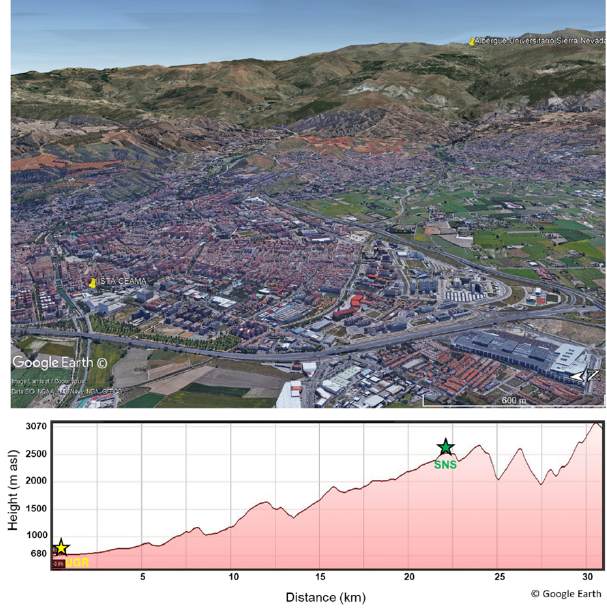
Figure 1. Map of Granada and Sierra Nevada and topographic pro- file between UGR and SNS stations. Yellow pins show the location of UGR and SNS